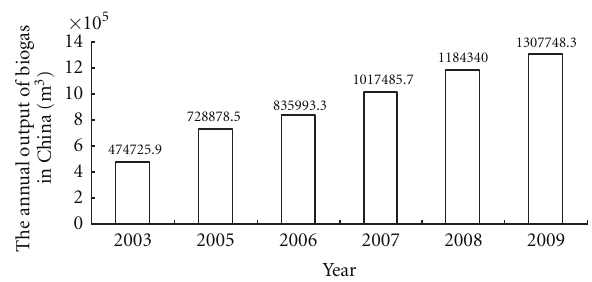
Figure 1: Bar chart of the number of biogas projects in